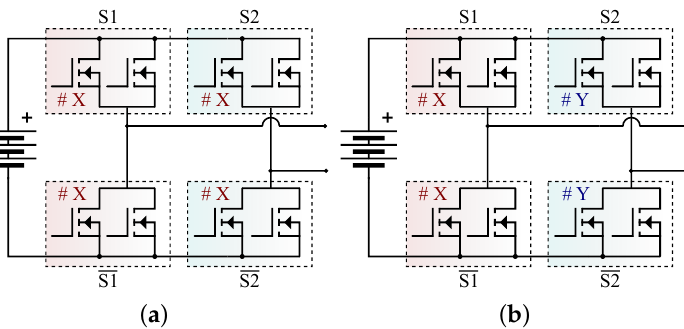
Figure 10. Inverter part number configuration for DSPLS. ( a ) Scenario where all MOSFETs have the same part number. ( b ) Scenario where different part numbers are considered for the different switching